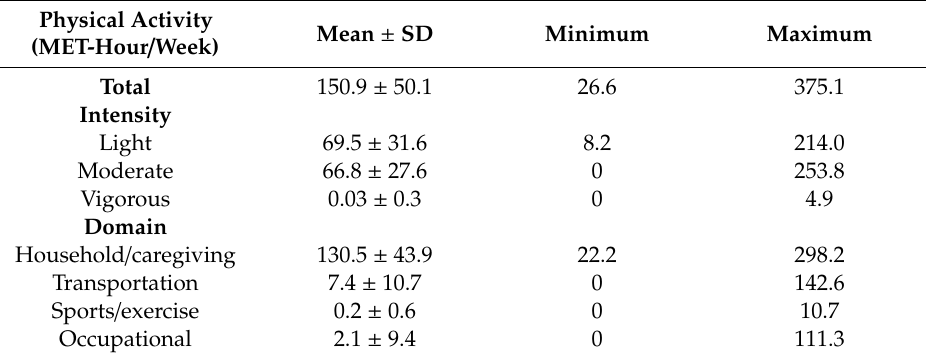
Table 2. Physical activity of the examined women at 3-month postpartum ( n = 1617).